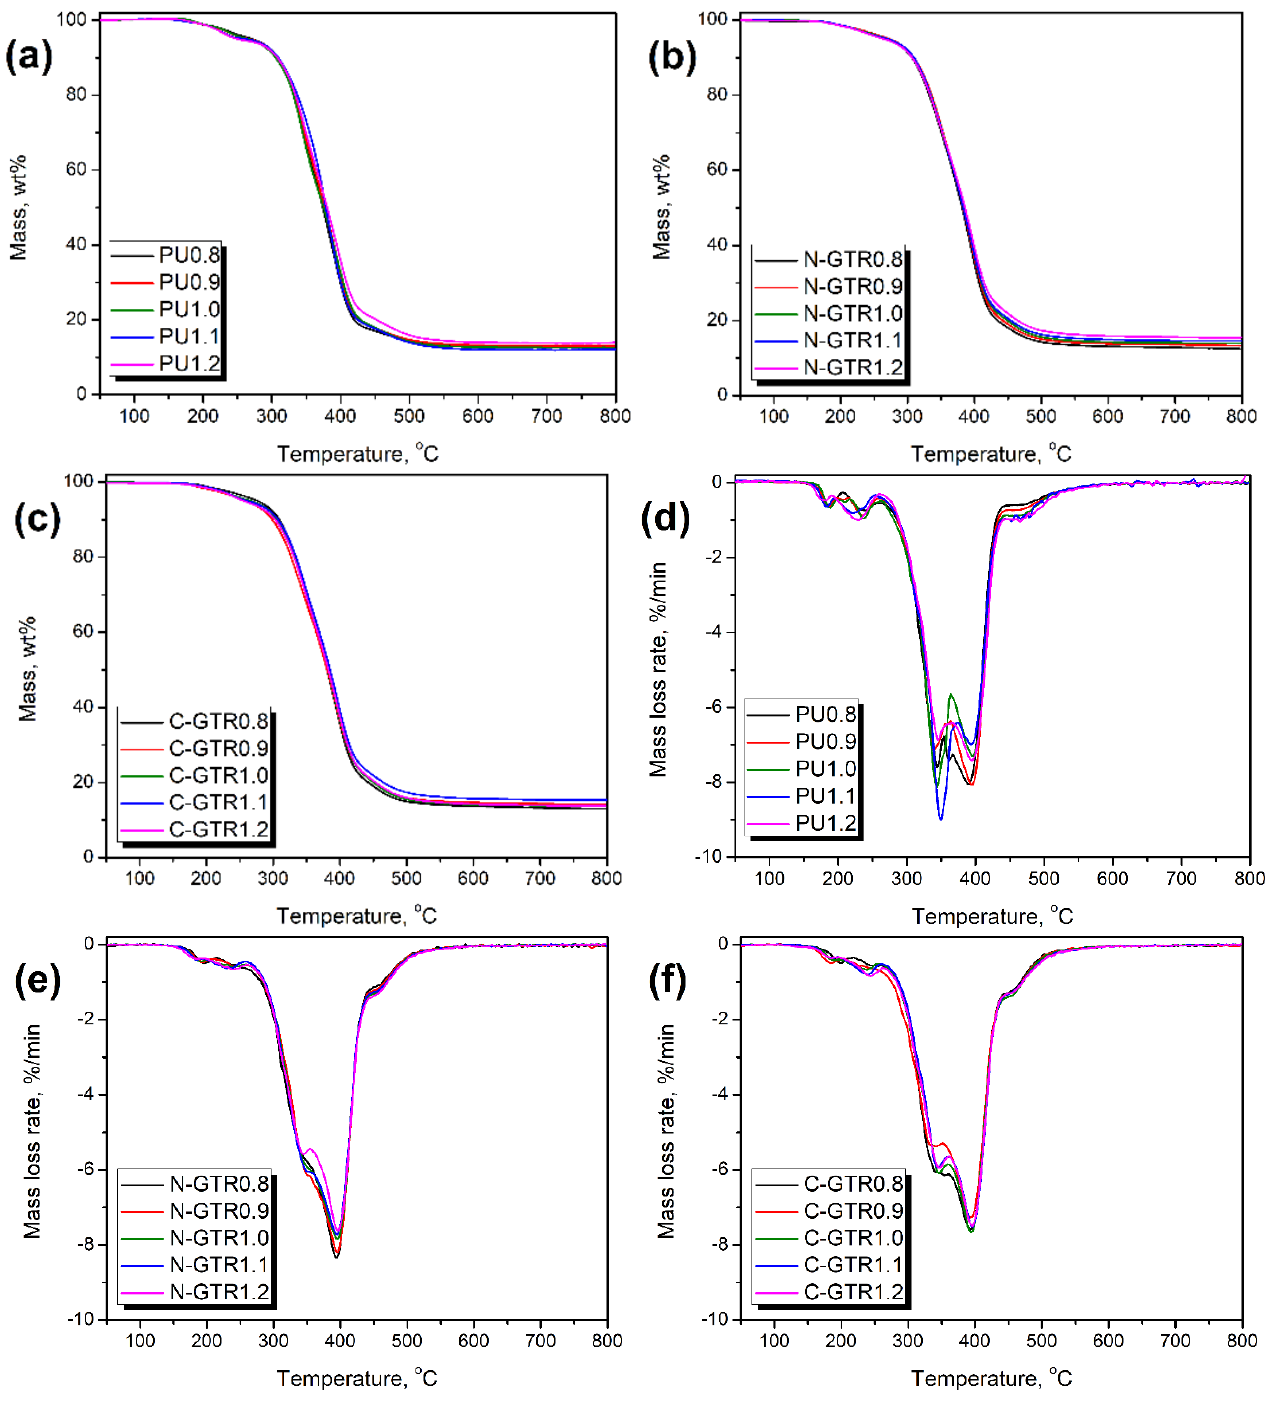
Figure 5. Mass loss curves for ( a ) PU foams, ( b ) N-GTR composites, and ( c ) C-GTR composites. Figure 5. Plots of ( a – c ) mass loss curves and ( d – f ) differential thermogravimetric curves for ( a , d ) unfilled PU foams and PU/GTR composites prepared ( b , e ) without, and ( c , f ) with considering the hydroxyl values of GTR during formulation